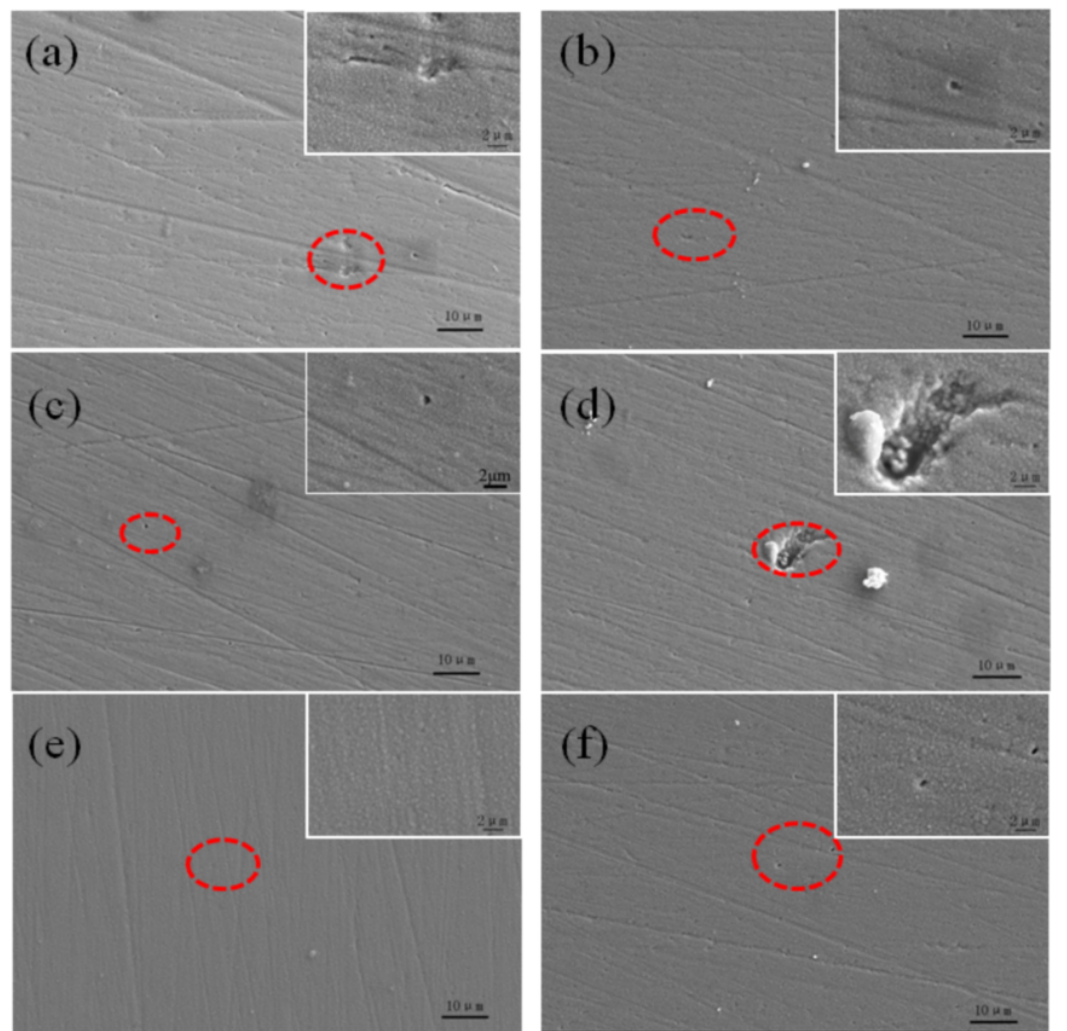
Fig. 8 The as-sintered surfaces of the sintered bodies for the 3Y-TZP with different backbone binders, whose pores originate from debinding: (a) L, (b) H, (c) P, (d) E/H, (e) L/H, (f)